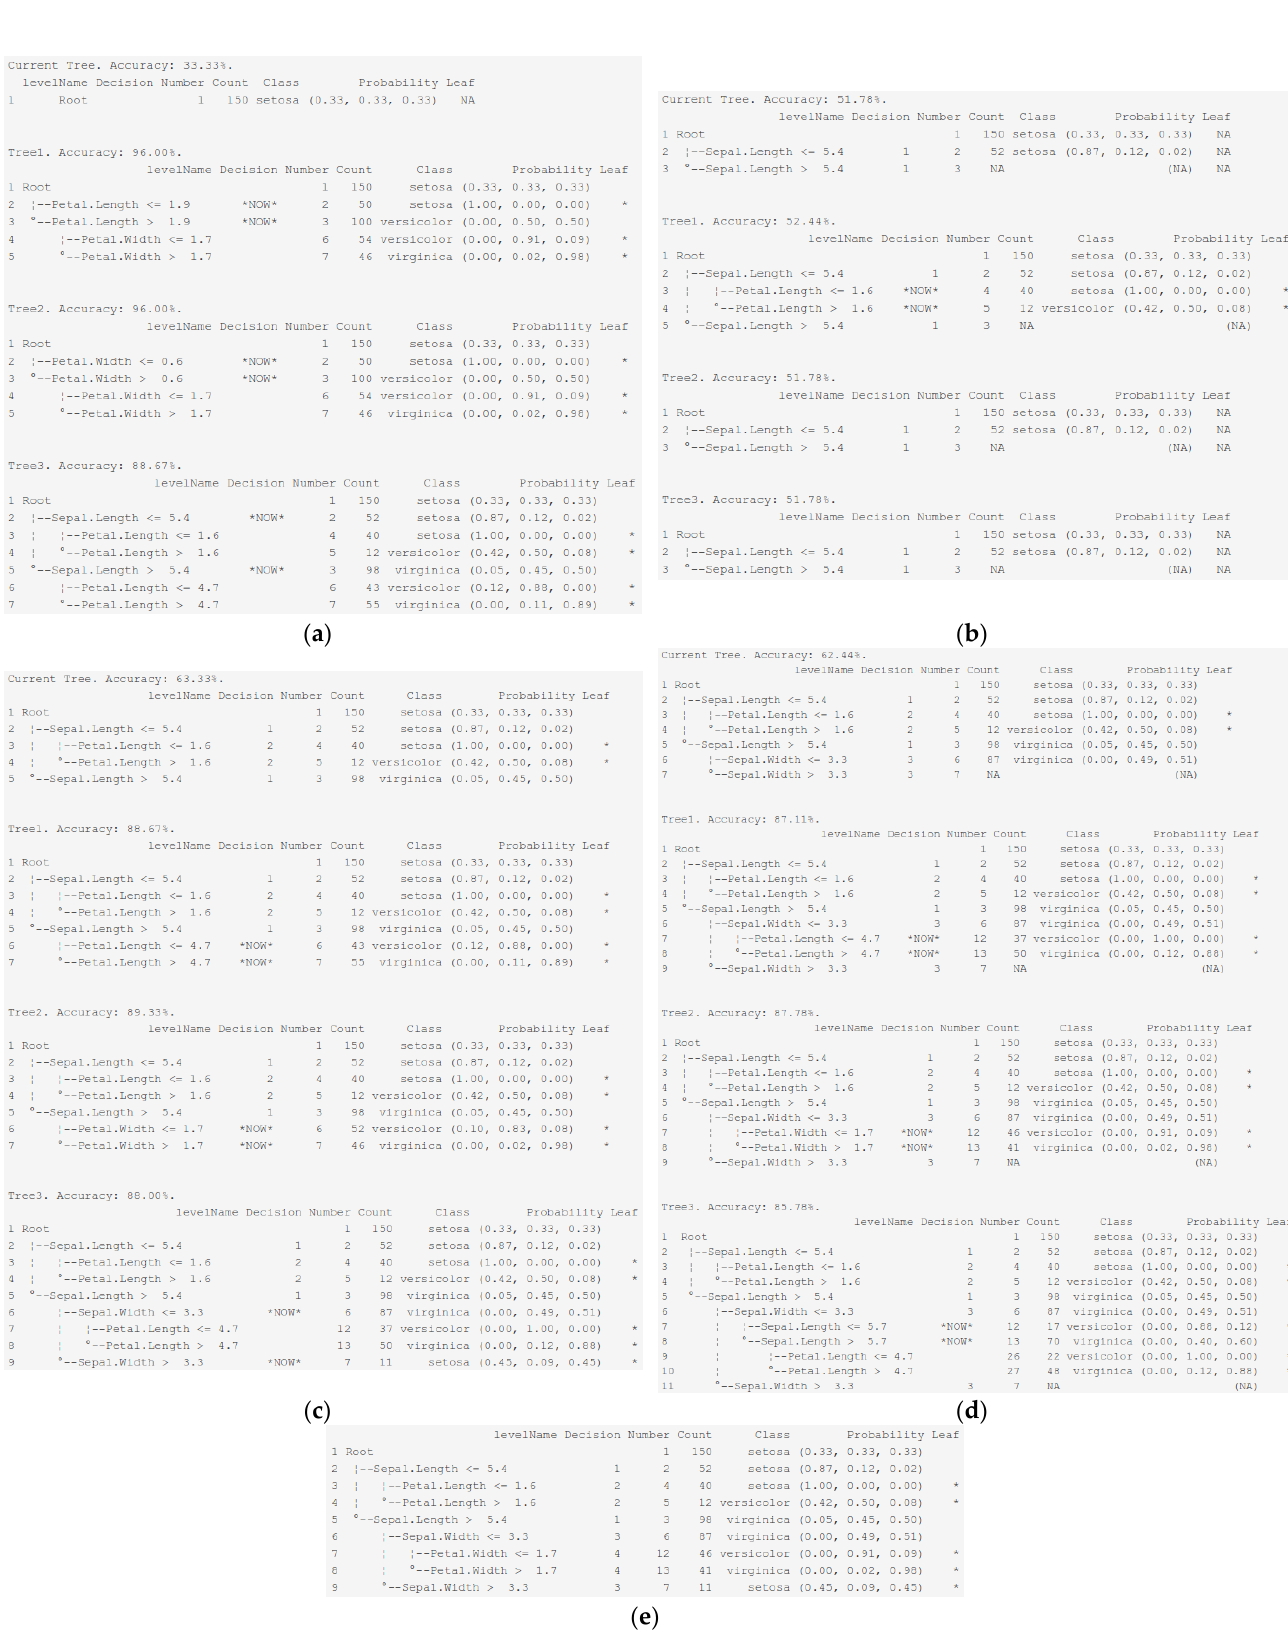
Figure 3. ( a – e ) Exemplary steps for interactive tree learning from scratch using the Iris data